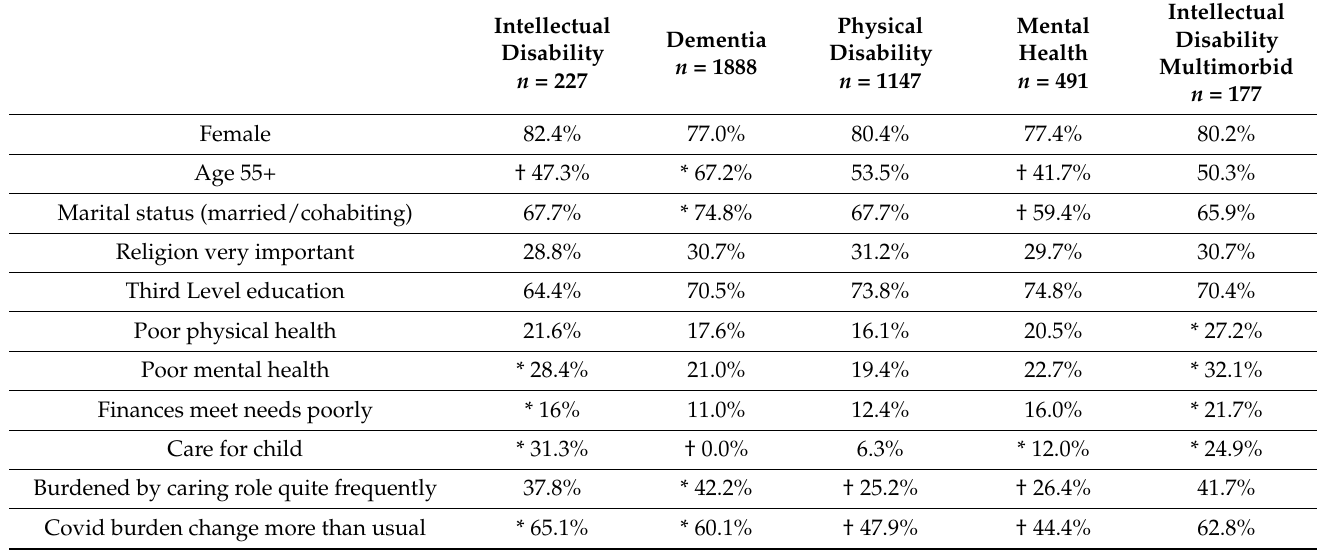
Table 1. Key demographics of carers in the CLIC